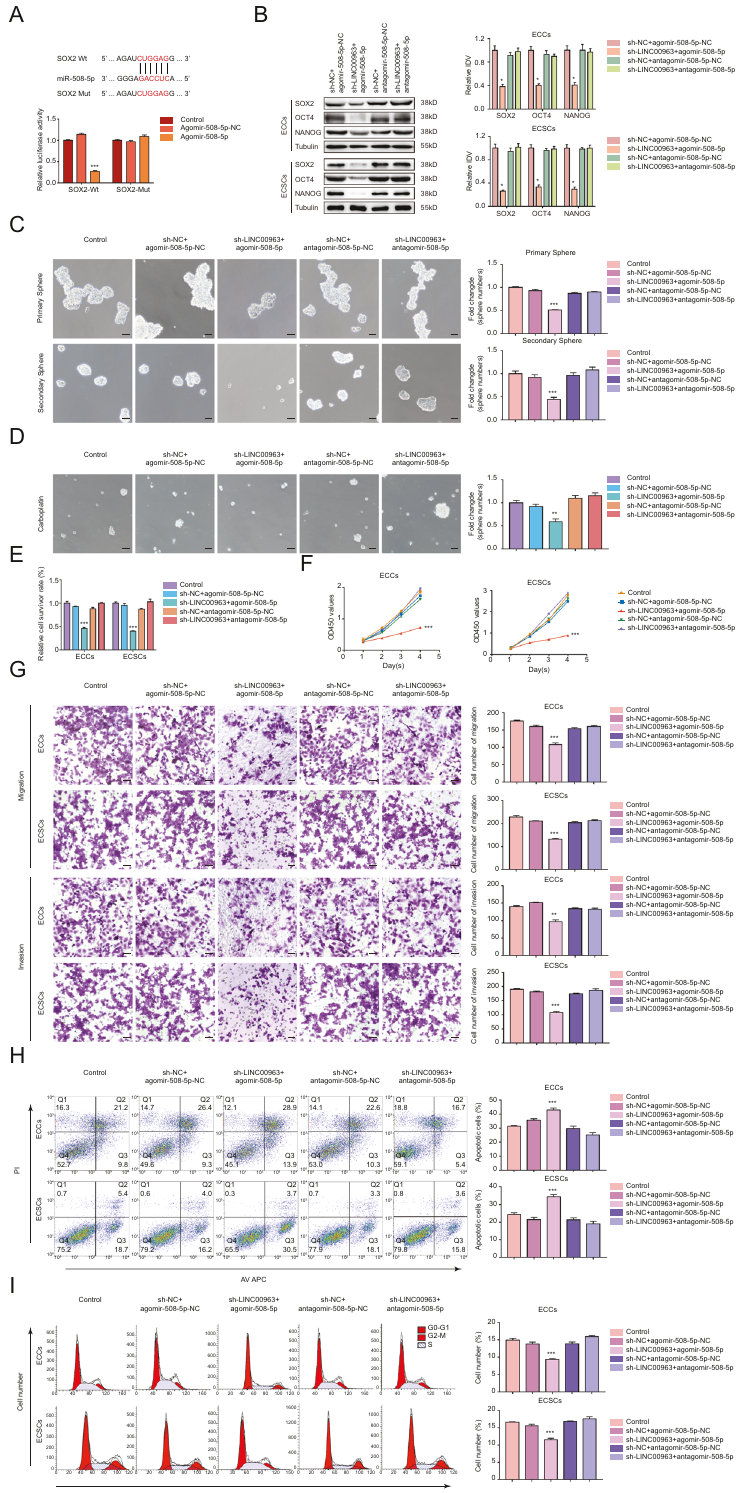
expression of SOX2, sphere-forming ability, carboplatin resistance, cell proliferation, migration and invasion, and cell cycle progres- sion prior to G2-M phase in the sh-LINC00963 + agomiR-508-5p group were markedly impaired, and the apoptosis proportion increased signi fi cantly (Fig. 7B – I). However, the